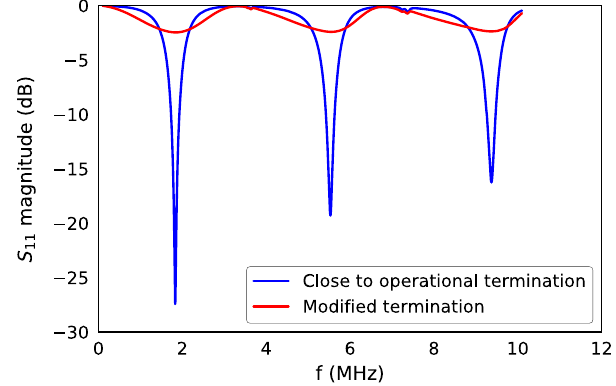
FIG. 18. Measurements of the S 11 reflection coefficient before (blue) and after (red) the modification of the filter